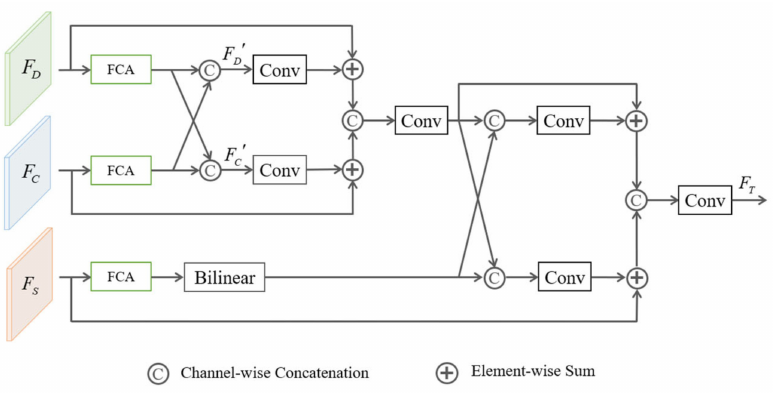
Figure 5. Three-Path Feature Fusion